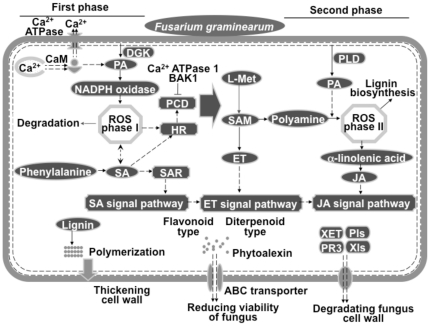
A model illustrating pathways leading to FHB resistance.PIs, protease inhibitors; XET, xyloglucan endotransglycosylase; Xls, xylanase inhibitors. See the text for other abbreviations. The peripheral solid lines indicate cell wall, the peripheral dotted lines indicate plasma membrane; the solid arrows represent direct interactions, and the dotted arrows represent indirect interactions. Perpendicular line on arrows indicates negative relationship.